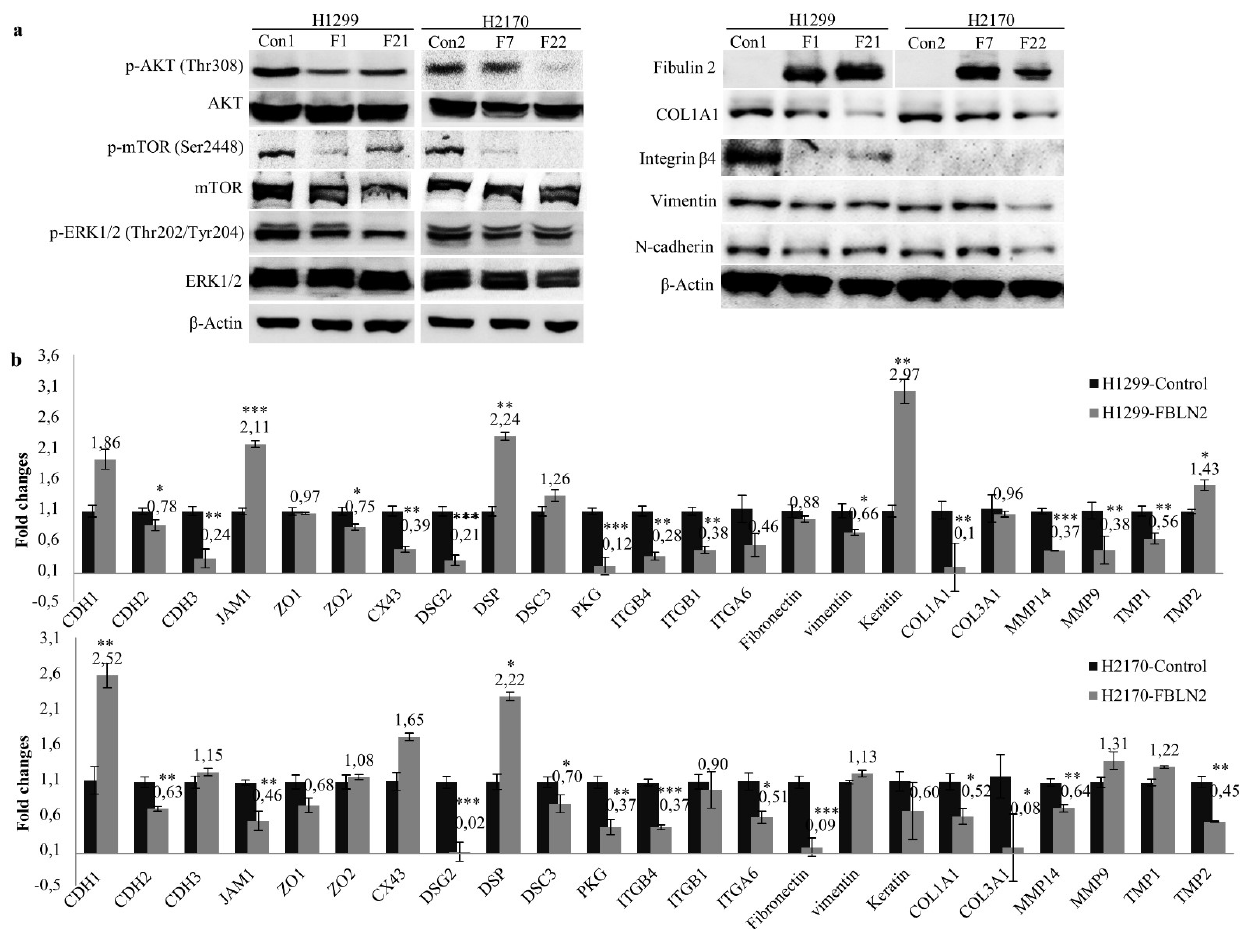
Figure 4. Influence of FBLN2 on regulation of MAPK and AKT pathways, cell adhesion molecules, and ECM associated genes. ( a ) Left: Reduced phosphorylated levels of ERK1/2, AKT and mTOR in FBLN2 transfected cells were determined by WB. Right: Decreased protein levels of cell adhesion molecules and ECM components in FBLN2 overexpressing cells were detected by WB. ( b ) A panel of cell adhesion molecules and ECM genes were measured by real-time RT-PCR in H1299 (top) and H2170 cells (bottom). mRNA expression level compared to GAPDH in mock cells was set to 1.0. * p < 0.05, ** p < 0.01, *** p < 0.001.